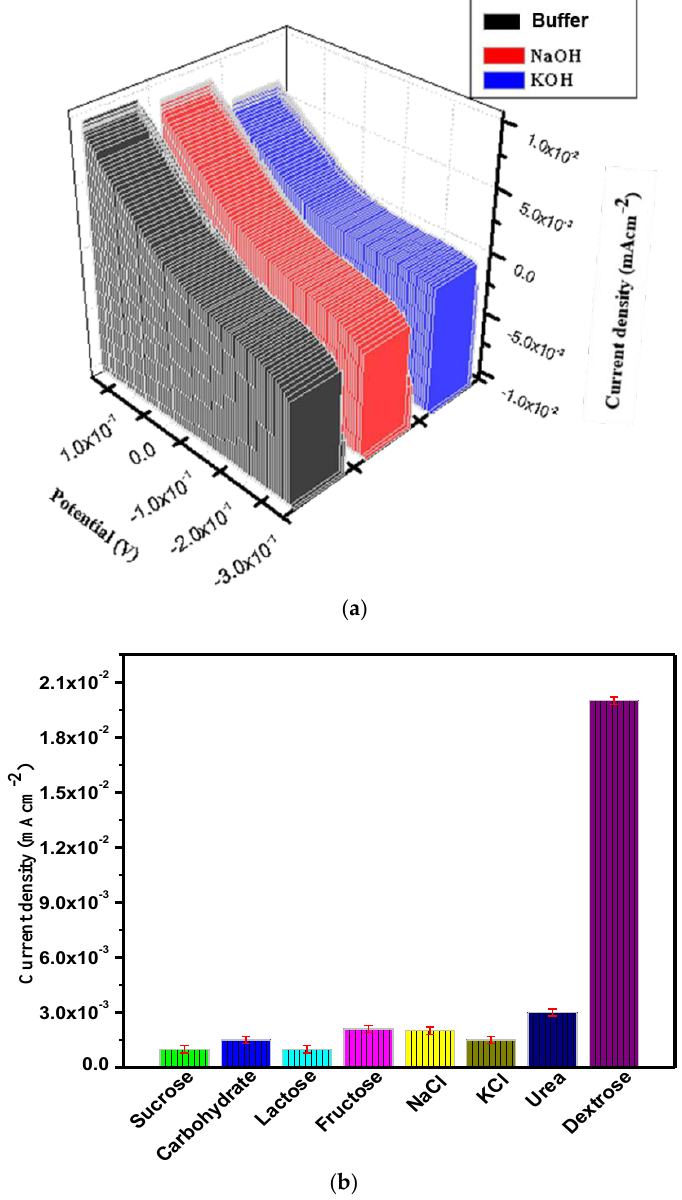
Figure 7. ( a ) Sensing of glucose by ZrO 2 -Ag-G-SiO 2 sample with different electrolytes: 0.1 M PO 43 − Buffer (pH 7.4); 0.1 M NaOH (pH 13) and KOH (pH 13.5) with the addition of 0.55 mmol/L glucose. ( b ) Selectivity test of glucose by the ZrO 2 -Ag-G-SiO 2 sample with 0.91 mmol/L (Vitamin C, Starch, Lactose, Fructose, NaCl, KCl, Urea, and Glucose) in 0.1 M PBS (pH 7.4). All experiments were run at room temperature (20 °C).